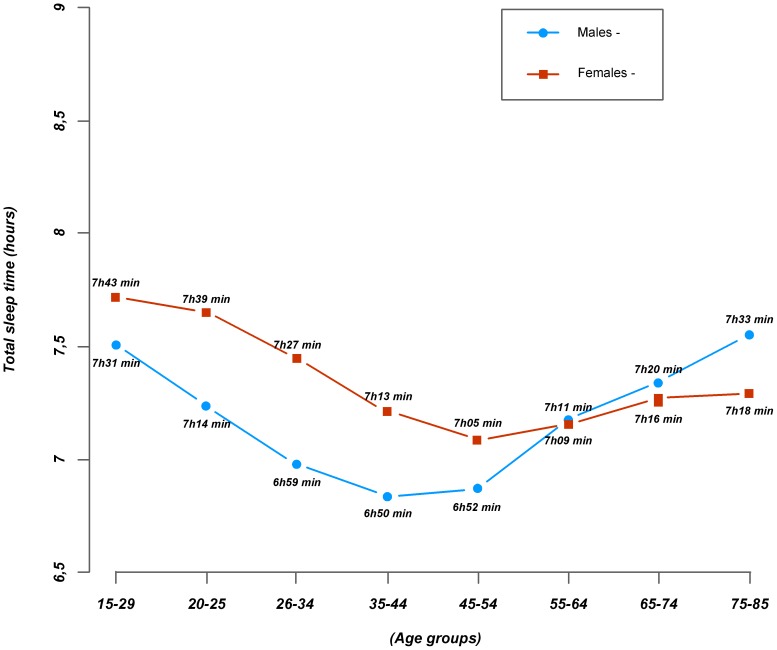
Data taken from the Health Barometer-2010, a nationally representative sample of 24,671 15-85-year-old participants questioned on their sleep duration.Total sleep time was defined as the difference between the time at which the participant switched off the light and the time of day they woke up, discounting the time needed to fall asleep.